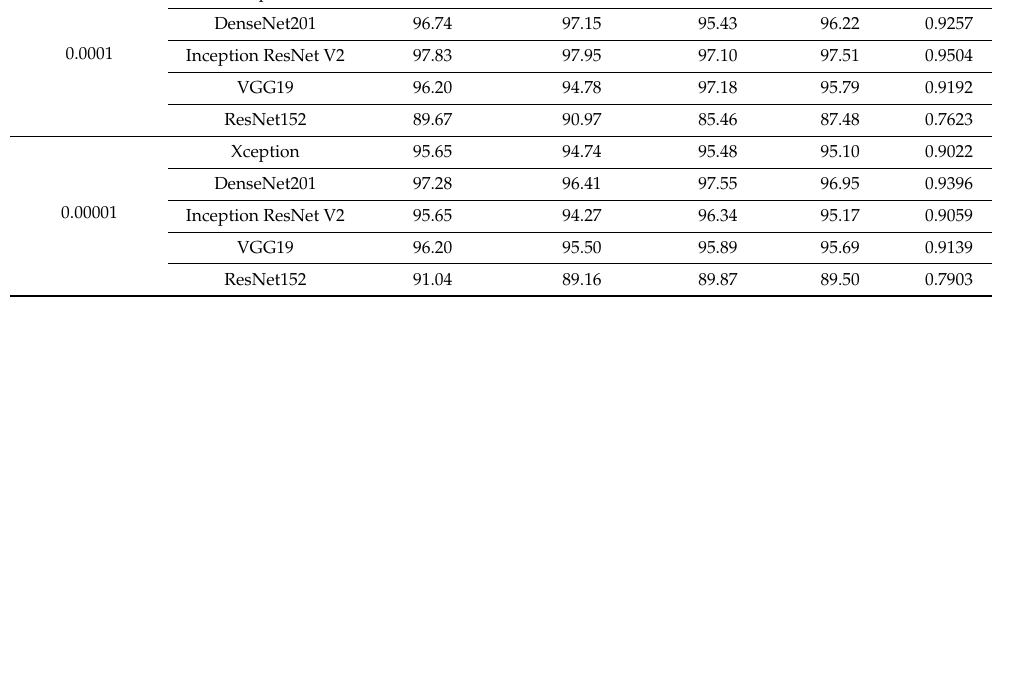
Table 8. Results of 400× magnification factor in binary classification mode; the highest results are shown in bold.